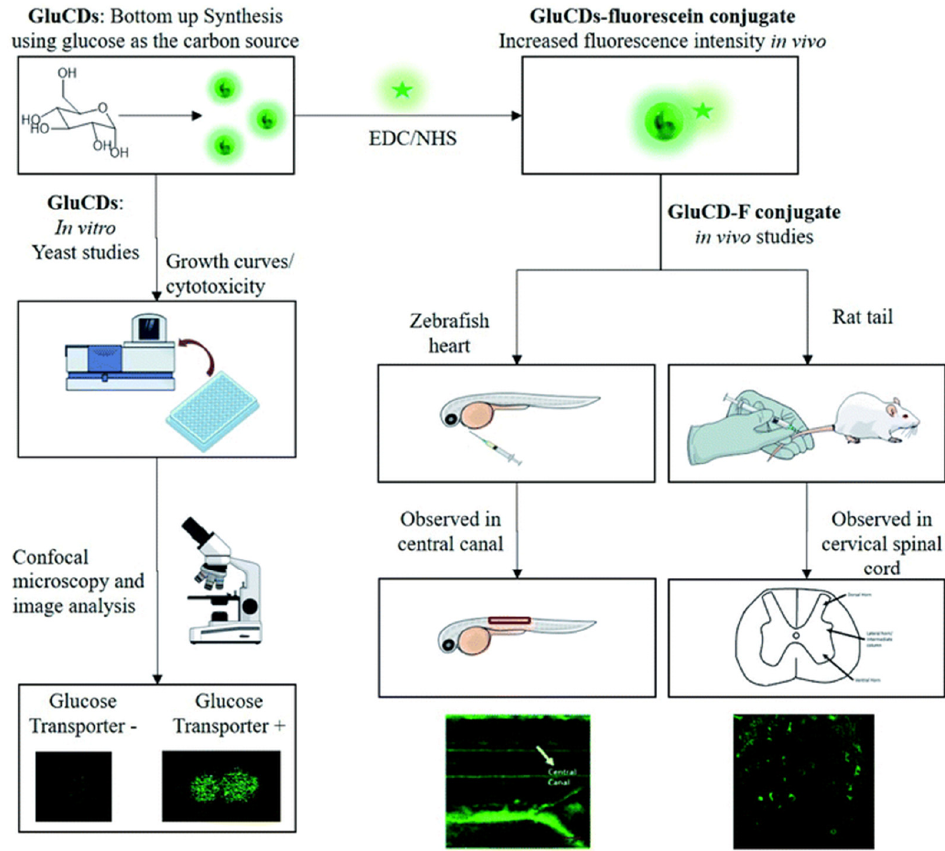
Figure 6. Diagram of in vivo and in vitro glucose CDs (GluCDs) transport. In zebrafish and rat models, GluCDs cross the BBB without the necessity for conjugation to a targeted ligand for receptor-mediated transport. GluCDs have the ability to convey cargo to the CNS. In a yeast model, the absorption process of GluCDs needs glucose transporter proteins. The figure was depicted from [114], which is unrestrictedly accessed and distributed under the Creative Commons Attribution 3.0 International License (http://creativecommons.org/licenses/by/3.0/ (accessed on 14 August 2022)).